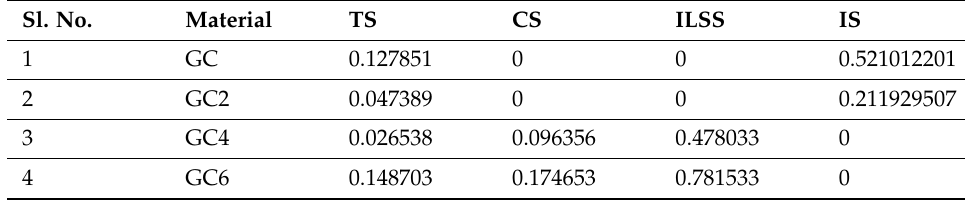
Table 7. Negative Distance from Average (NDA).